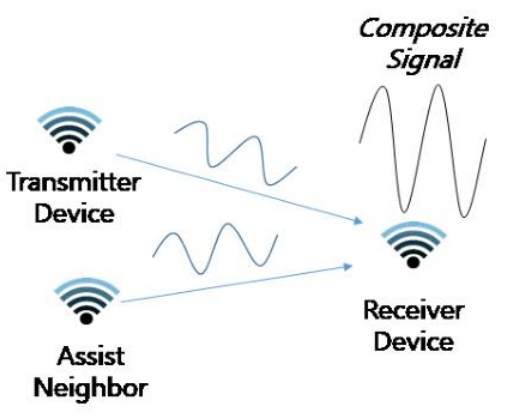
Figure 2. Amplify and forward